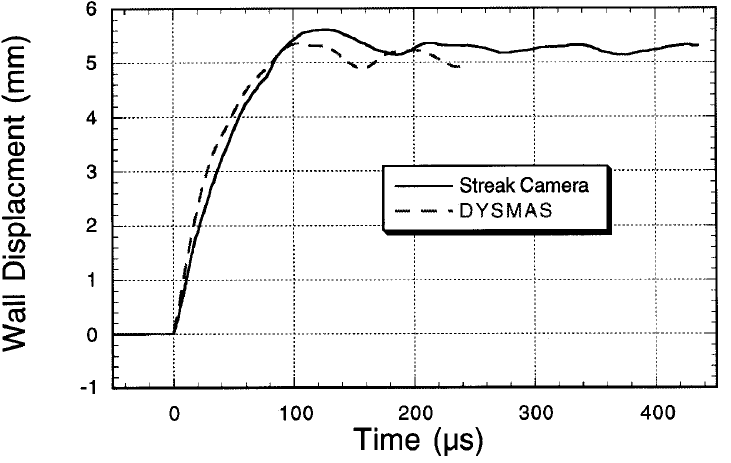
Fig. 6. Comparison of wall displacement for shot SV-3 with DYSMAS calculations.